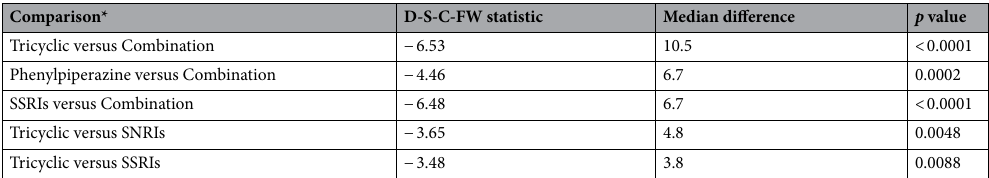
Table 3. Pairwise comparisons of antidepressants on mental HRQoL using the Dwass–Steel–Critchlow– Fligner test. SSRIs: Selective serotonin reuptake inhibitors; SNRIs: Serotonin and norepinephrine reuptake inhibitors; Combination: Patients using multiple antidepressants. *Only significantly different results are listed.